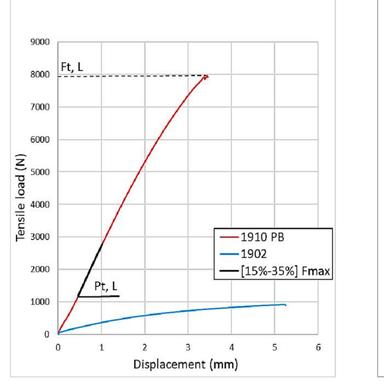
Representative example of the behavior curves of corrugated panels and measurements of their properties, as well as the behavior curves of ten 1910Pb panel samples under longitudinal tensile loading.